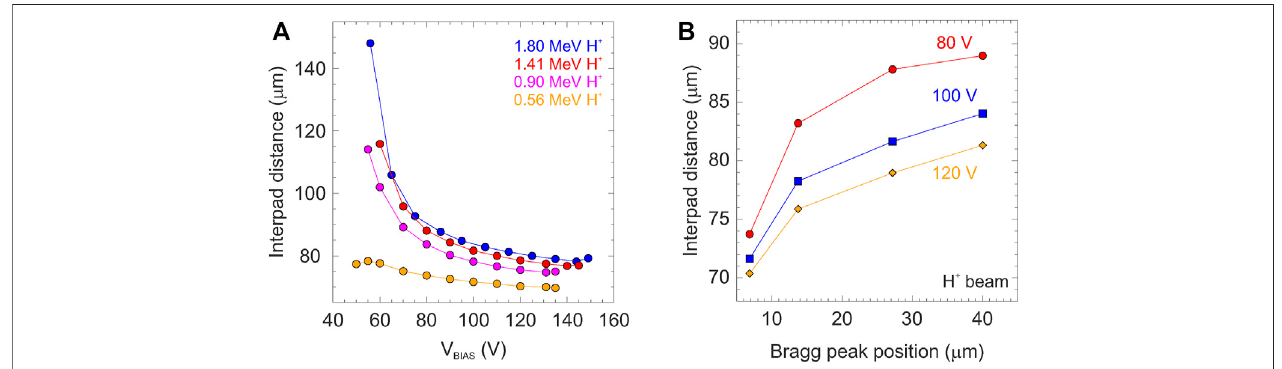
FIGURE 5 | (A) Interpad distance measurements results for sample A, shown as a function of proton energy used. (B) Interpad distance measured for 3 bias voltages shown as a function of probing depth represented by a median of the ionization pro fi le Bragg